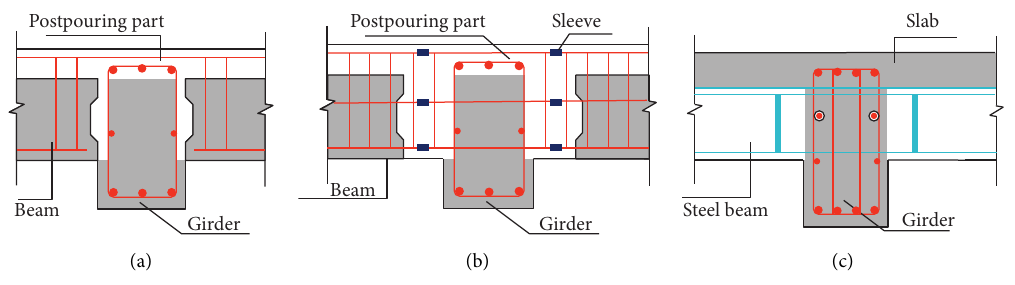
Figure 2: Improved beam-girder